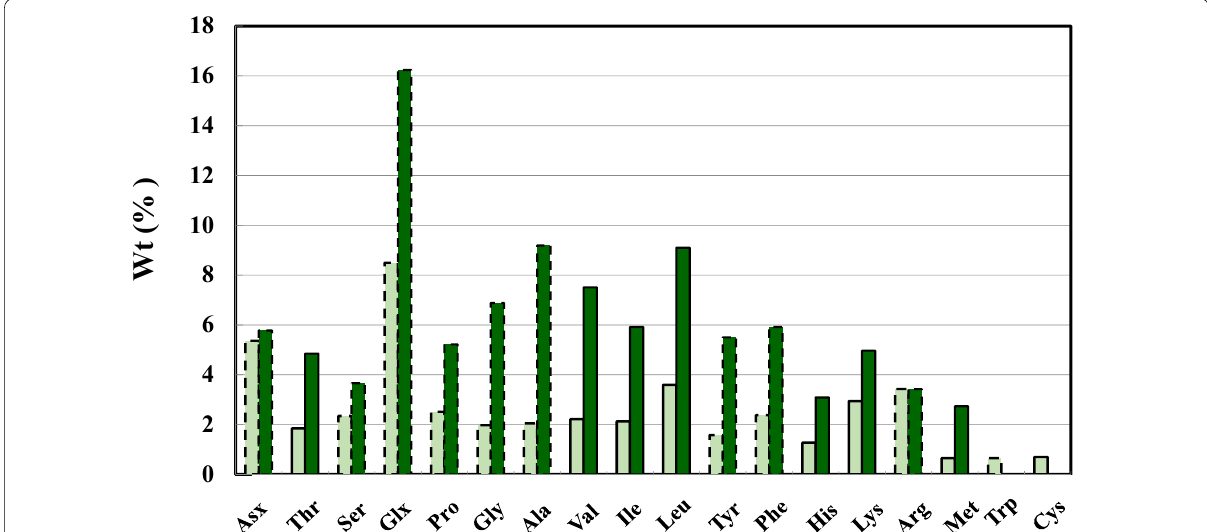
Fig. 5 AA compositions of PH II, shown by the dark green bars. The ordinate represents the wt% on dry matter basis, while the abscissa refers to the AA residues. The light green bars represent the AA composition of soybean meal. The bars with the broken line refer to unessential AAs, while those with the solid line are the essential AAs for hog and poultry. Asx asparagine and aspartate, Glx glutamine and glutamic acid